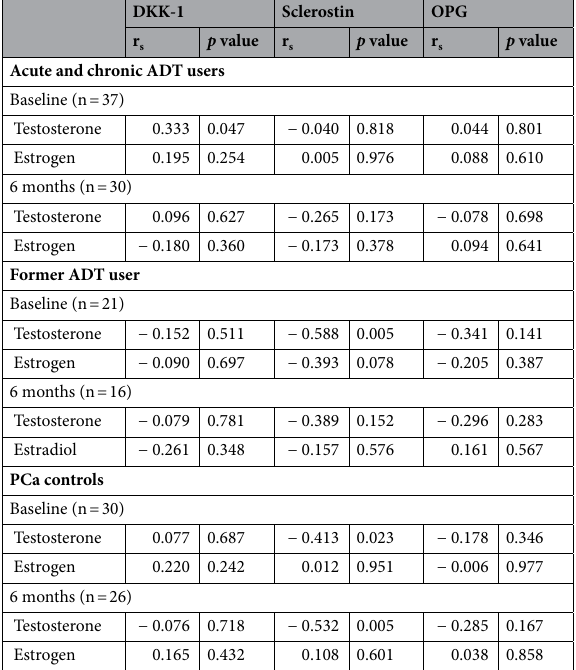
Table 5. Correlations between bone markers and sex steroids. DKK1 Dickkopf-1, OPG